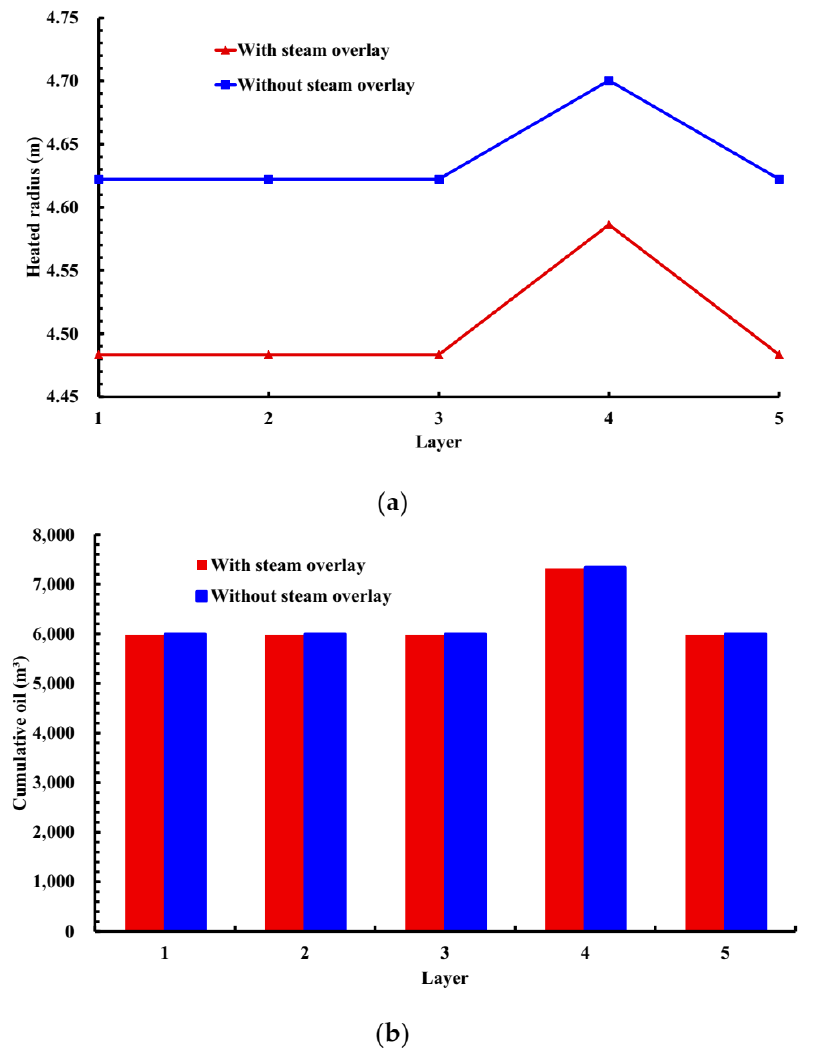
Figure 8. Calculation results on the effect of the steam overlay—( a ) Heating radius; ( b ) Cumulative oil